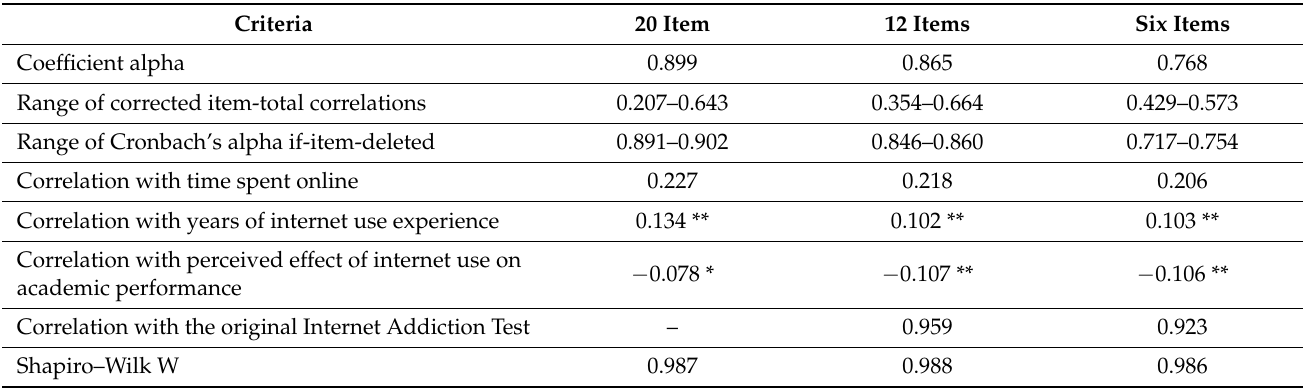
Table 9. Internal consistency, criterion validity, and normality tests of the Internet Addiction Test (20 items, 12 items, and six items) in a sample of university students ( N =